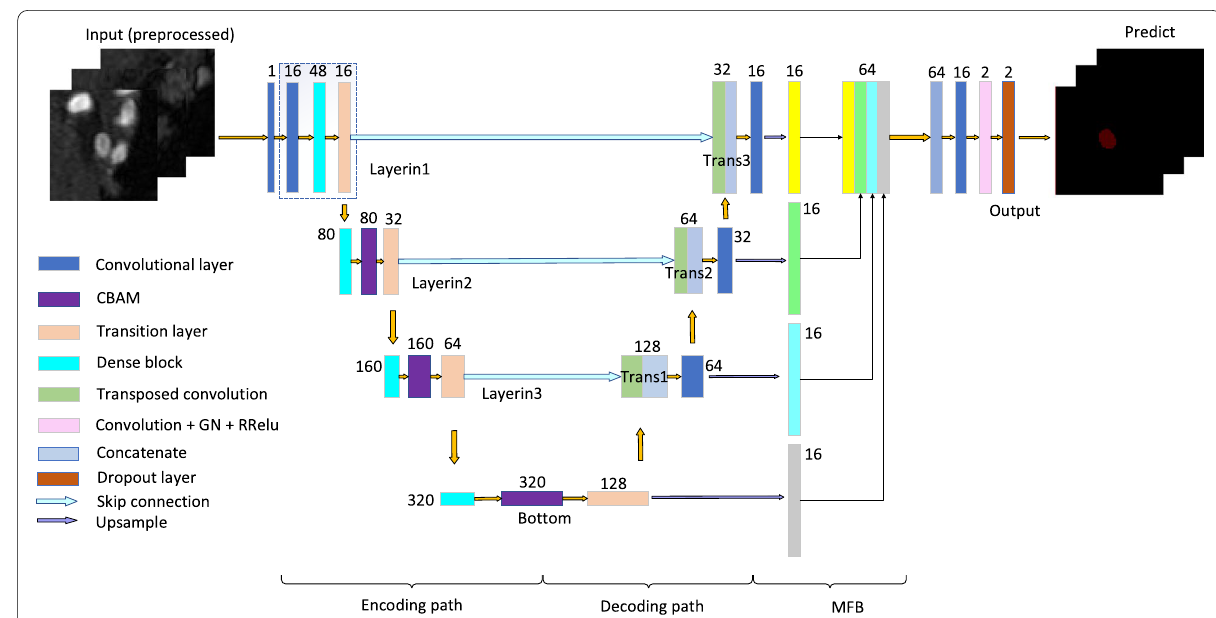
Fig. 2 Schematic of the proposed network (DCAU-Net). The framework is shown in the 2D form, for the sake of convenient